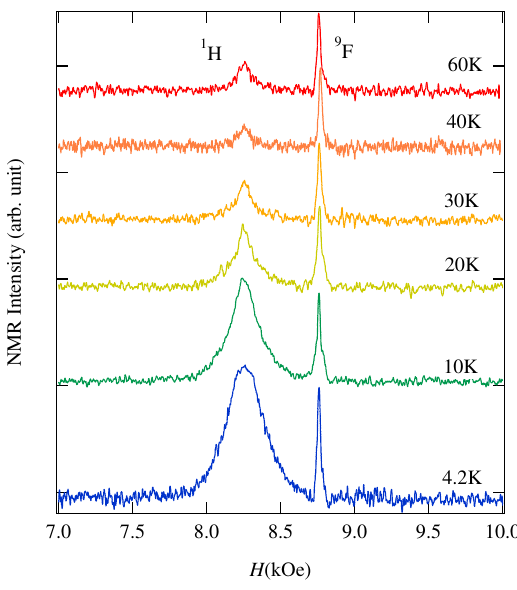
Figure 3: 1 H-NMR spectra for LaFeAsO 0 . 4 H 0 . 6 mea- sured at 3.7 GPa and 35.1 MHz. The 9 F signal orig- inates from the pressure-transmitting medium, a mix- ture of Fluorinert FC-70 and FC-77.